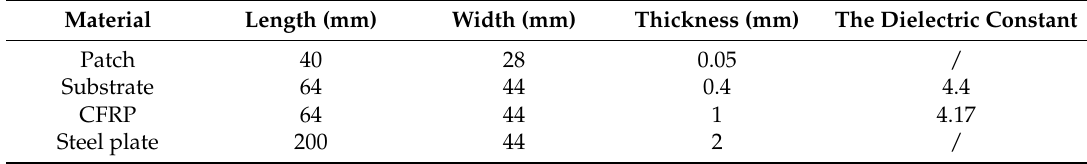
Table 5. Geometrical factors and material properties of carbon fiber reinforced polymer (CFRP).